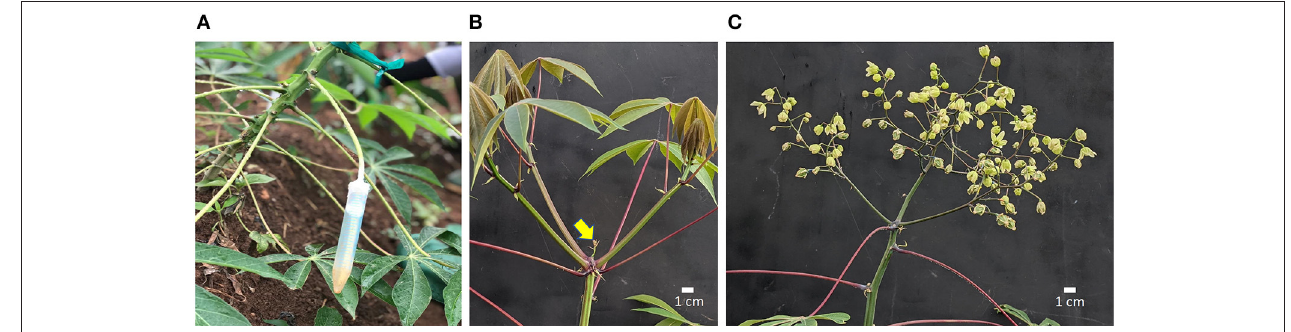
FIGURE 1 | Cassava inflorescence development following treatments. (A) Method of PGR application by petiole feeding; (B) Control fork-type branching with three developing branches; inflorescence aborting (arrow); (C) Inflorescence (flowers and fruit) on a plant that received STS + BA and pruning. Scale bar indicates 1cm. STS, silver thiosulfate; BA, benzyladenine; PGR, plant growth